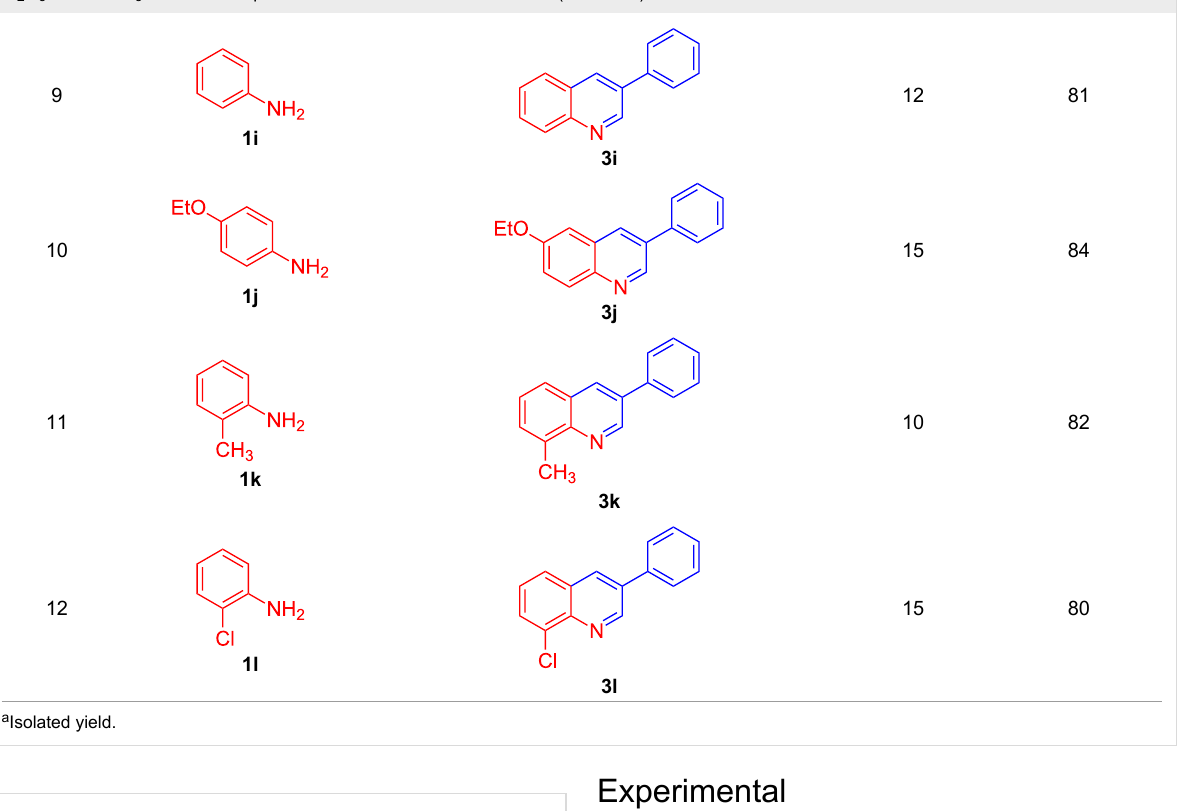
Table 2: One-pot synthesis of 3-arylquinolines from the reaction of different anilines (1.0 mmol) with styrene oxide (2.0 mmol) in the presence of Al